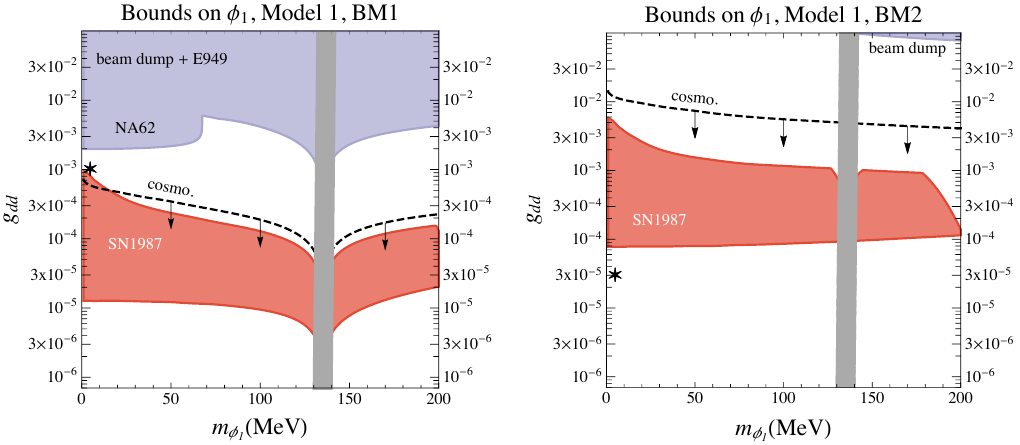
Figure 13 . The constraints on the g dd coupling in BM1 (left) and BM2 (right) due to couplings of (cid:30) 1 to photons and nucleons as a function of the (cid:30) 1 mass. The purple regions are excluded by (cid:25) + X ) and NA62( (cid:25) 0 beam dump searches, E949 ( K + inv), the red region by SN1987, while ! ! the dashed line shows the upper bound from cosmology in the absence of any other light states or (cid:30) 1 -couplings. The star denotes the values of g dd and m (cid:30) in (cid:12)gure 5 ((cid:12)gure 6) for BM1 (BM2). 1 m The region around m (cid:30) (cid:25) 0 is masked out (gray region). 1 ’ of (cid:30) 1 is suppressed su(cid:14)ciently that it again does not contribute appreciably to the cooling of PNS. BM2 falls in this regime, see eqs. (3.67),